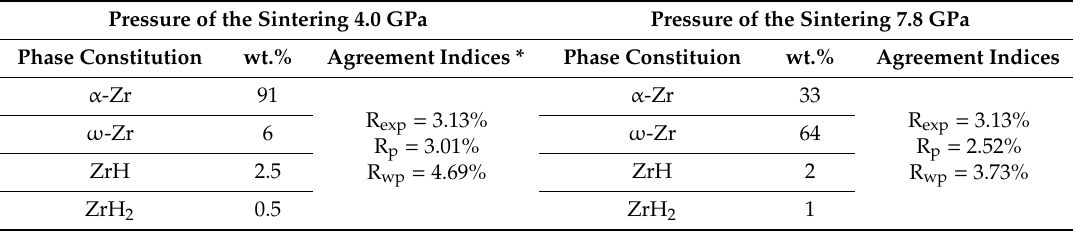
Figure 7. The X-ray diffractograms of the Zr 1 powder sintered at 4.0 GPa and 7.8 GPa, at a temperature of 1273 K. Table 3. The qualitative and quantitative composition data of sintered Zr 1 powder (sintering conditions: T = 1273 K, t = 1